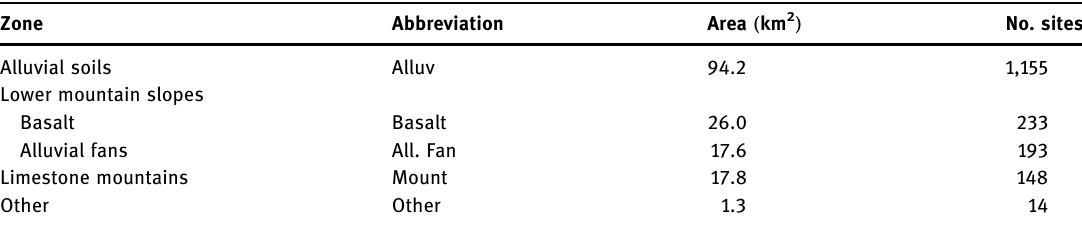
Table 3: Geological zones in the Yautepec